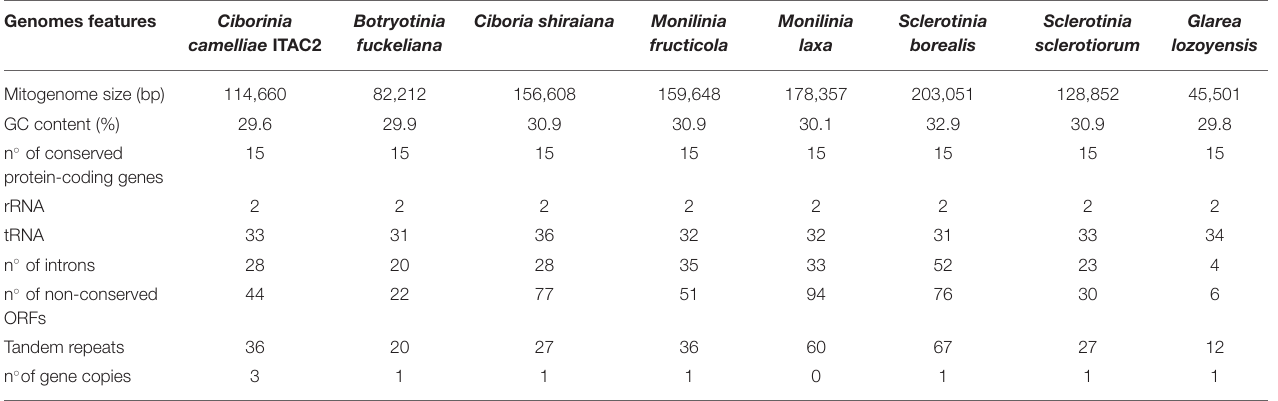
TABLE 4 | Comparison of Ciborinia camelliae strain ITAC2 mitogenome (OK326902) with closely related species: Botryotinia fuckeliana (KC 832409), Ciboria shiraiana (CM 017871.1), Monilinia fructicola (NC_056195.1), Monilinia laxa (NC_051483.1), Sclerotinia borealis (KJ434027), Sclerotinia sclerotiorum (KT283062) and Glarea lozoyensis (NC_031375.1) as